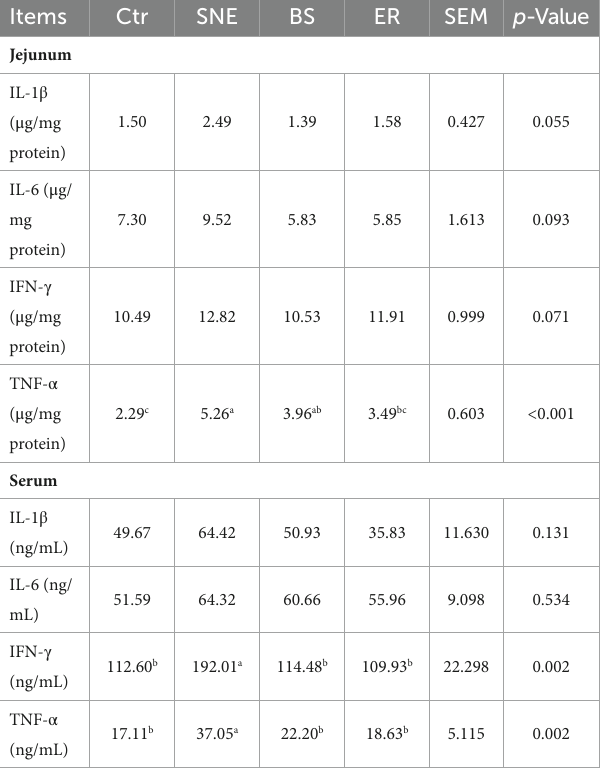
TABLE 5 Effects of Bacillus subtilis DSM29784 treatment group on the cytokine secretion in serum and jejunum of broiler. Items